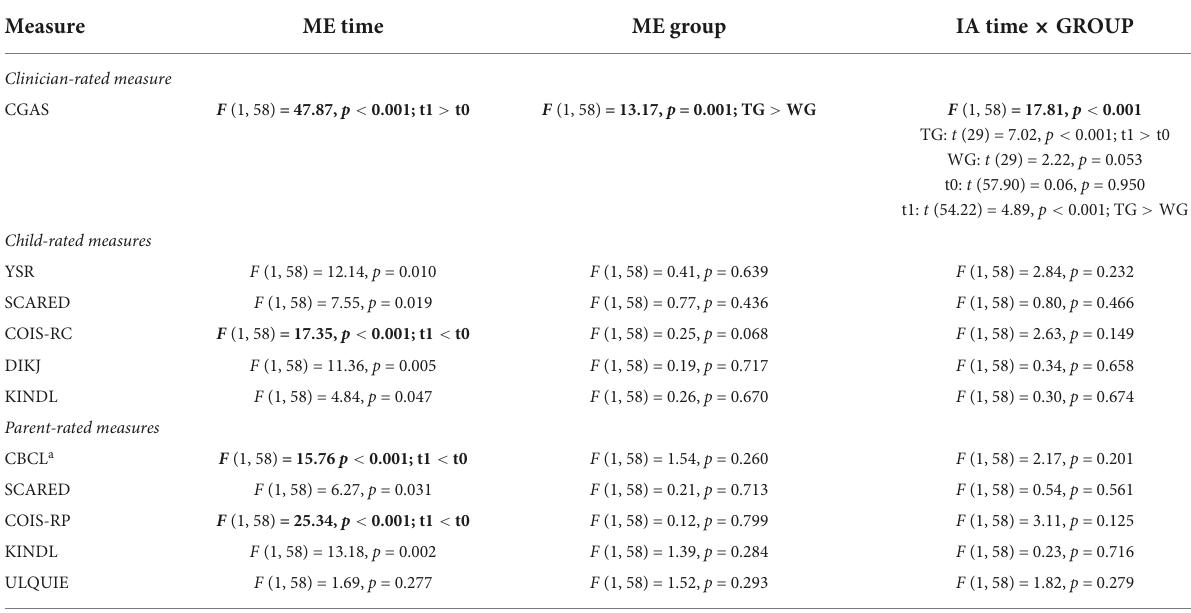
TABLE 3 Statistical analyses of secondary outcome measures—treatment effects. Mixed two-way ANOVA with the factors group (treatment, waiting list) and time (t0, t1)